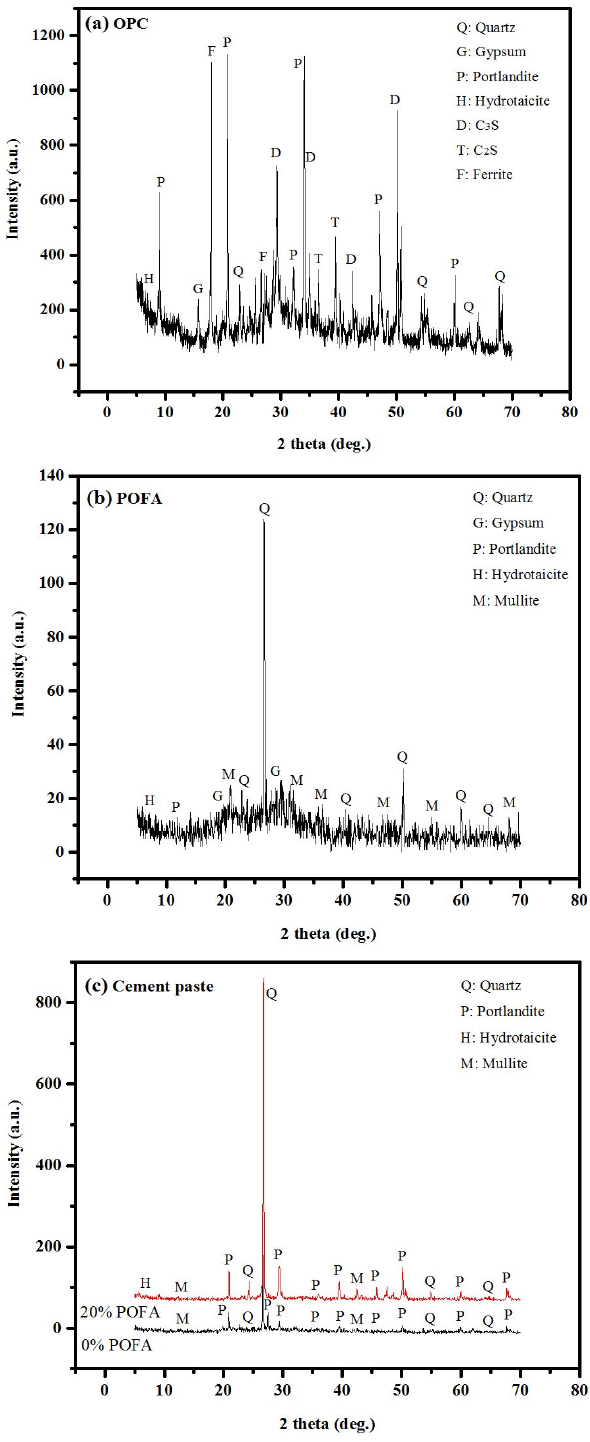
Figure 14. XRD pattern of ( a ) cement raw material, ( b ) POFA ash powder, and ( c ) cement pastes of binary blend.